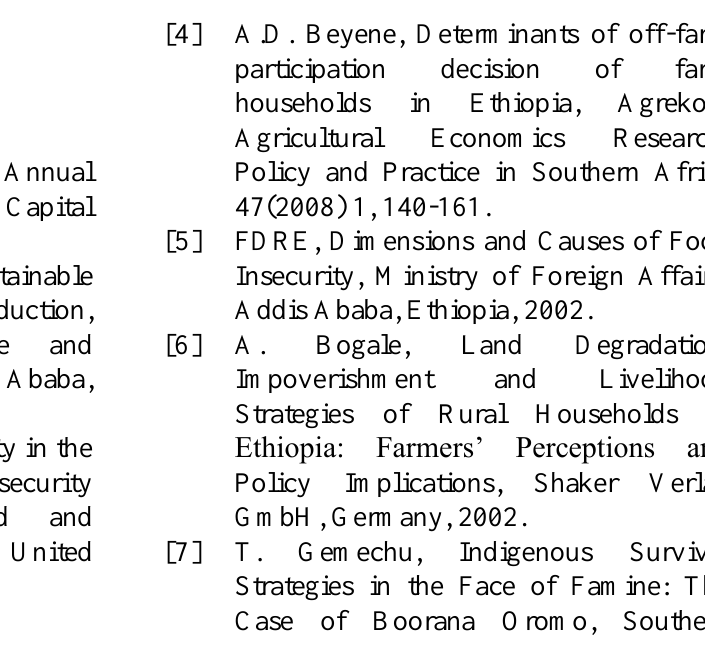
Questions/Responses and household